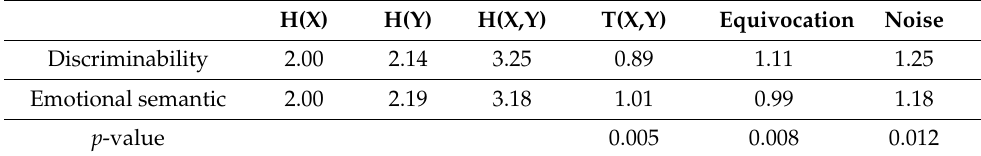
Table 13. Results of information theory-based analysis of the two haptic signal